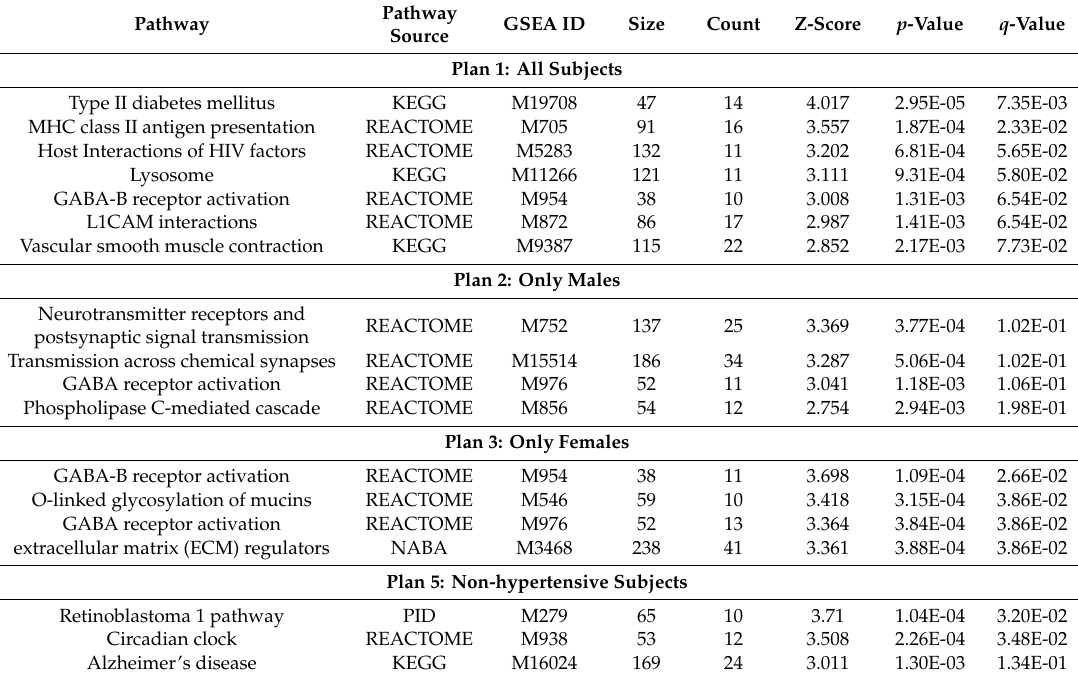
Table 4. Pathway-enrichment of blood-based methylome-wide association results.